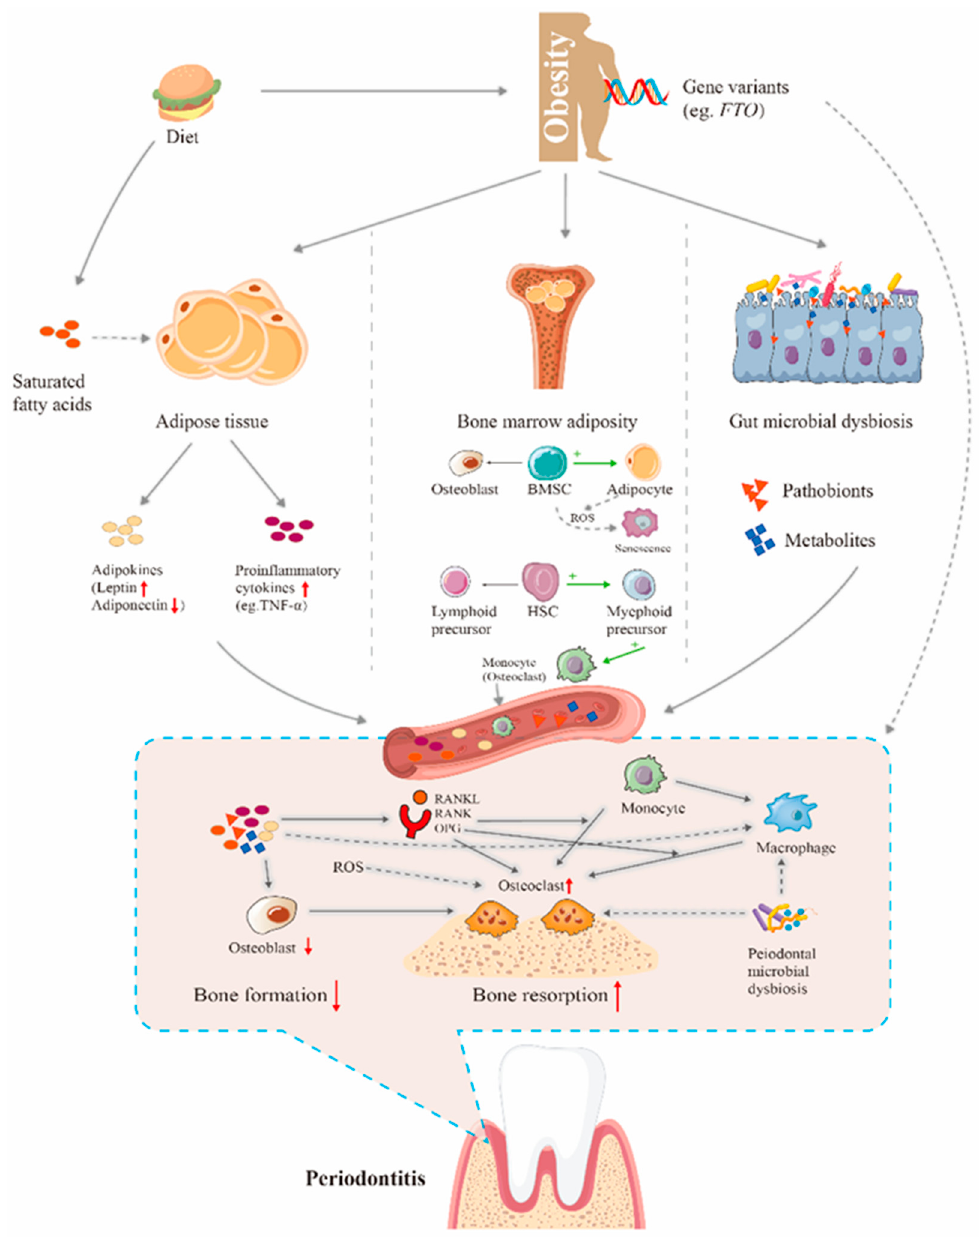
Figure 1. Mechanisms underpinning obesity-related systemic and alveolar bone loss. In obesity, excessive or unhealthily expanded white adipose tissue leads to the dysregulation of adipokines and inflammatory cytokines production. Apart from that, bone marrow adiposity is associated with the adipogenic differentiation of bone marrow stem cells (BMSCs) and the disruption of